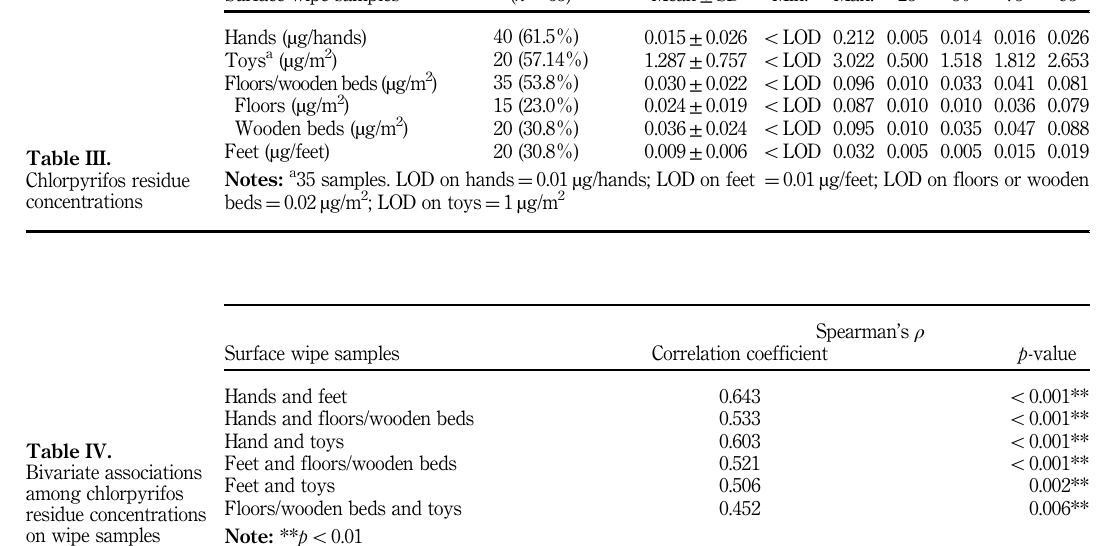
Table IV. Bivariate associations among chlorpyrifos residue concentrations on wipe